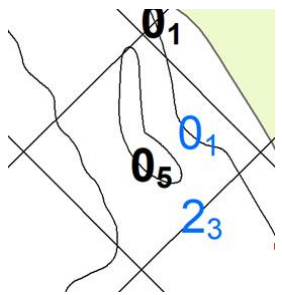
Figure 6. Fill deep soundings selection (olive—Fill deeps, green—Fill shoals, pink—Prime deeps, red—Prime shoals, blue—Background): (top image) selected soundings based on deep criteria and (bottom image) retained soundings based on distance criteria.